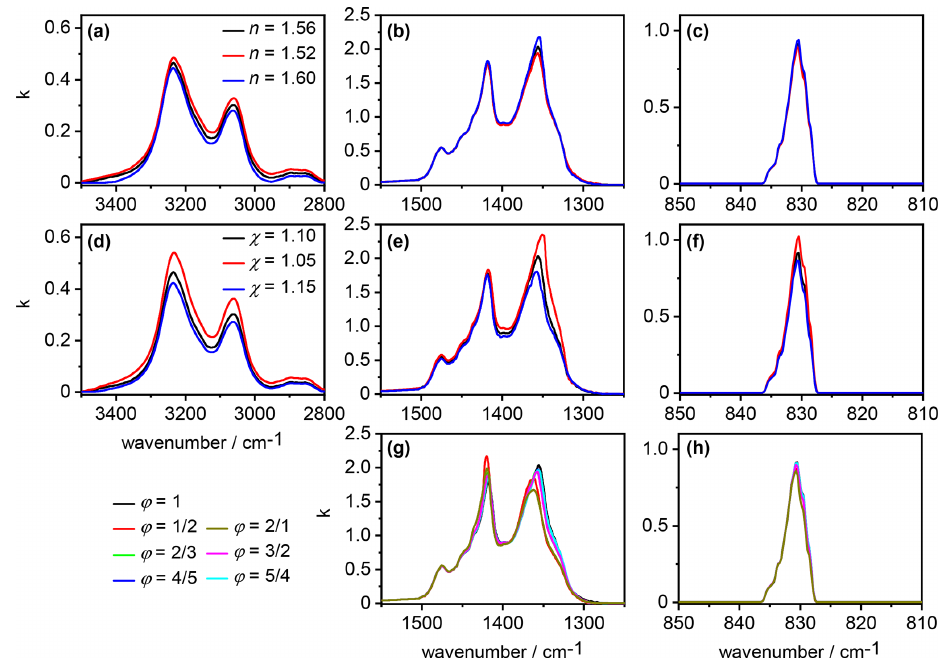
Figure 5. Sensitivity of the retrieved k( ˜ ν) spectrum on the parameters n( ˜ ν x ) , χ , and ϕ in different wavenumber regimes. (a–c) Variation of n( ˜ ν x ) with χ = 1 . 1 and ϕ = 1. (d–f) Variation of χ with n( ˜ ν x ) = 1 . 56 and ϕ = 1. (g, h) Variation of ϕ with n( ˜ ν x ) = 1 . 56 and χ = 1 .